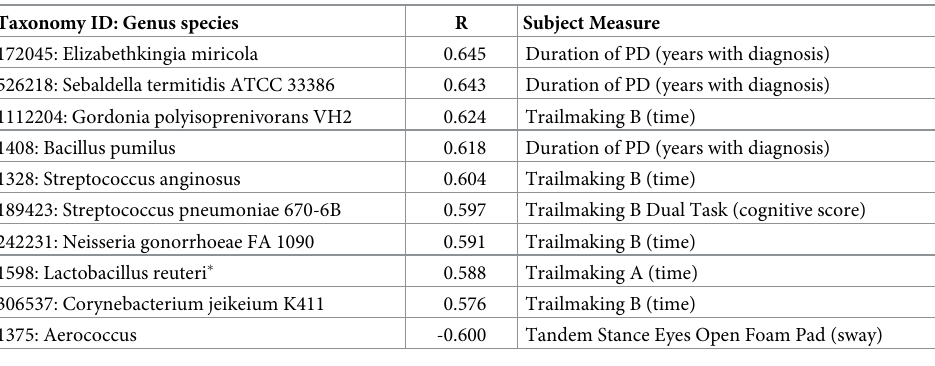
Table 6. Top microbial correlations with medical/demographic/functional